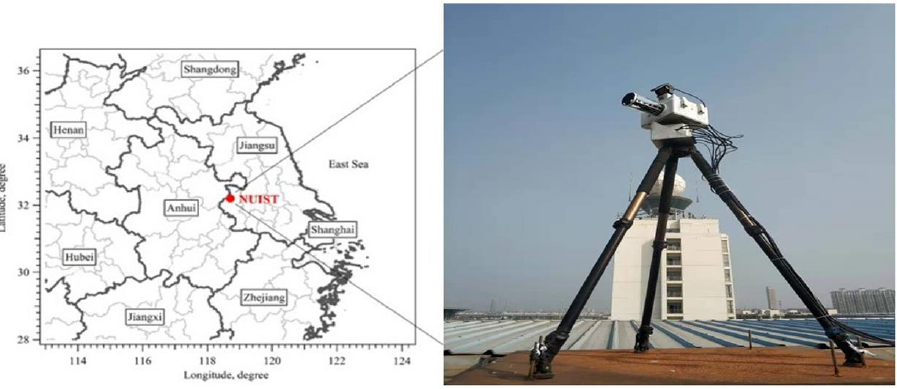
Figure 1. The observation site at Nanjing University of Information Science and Technology, Pukou, Nanjing, China.